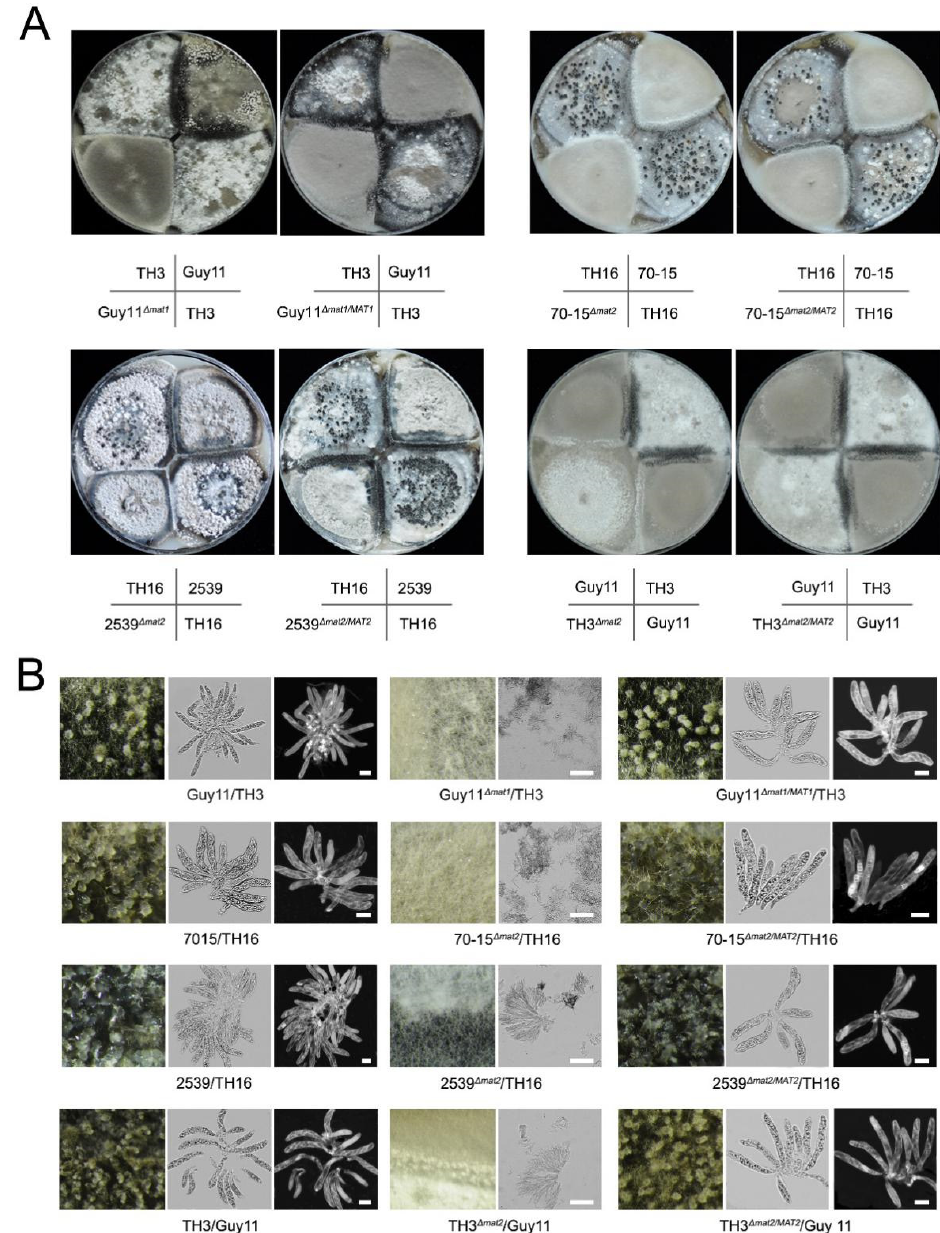
Figure 1. Characterizing the function of MAT loci in sexual development by the gene deletion strategy. ( A ) Comparison of the development of perithecia of wild-type, MAT loci mutants and recovery strains by crossing with their partner strains on OMA plates; ( B ) the perithecia generated in different combinations were observed in 60 × magnification under a stereomicroscope, and the asci were stained with calcofluor white and detected under a fluorescence microscope. Bars = 20 μ m.